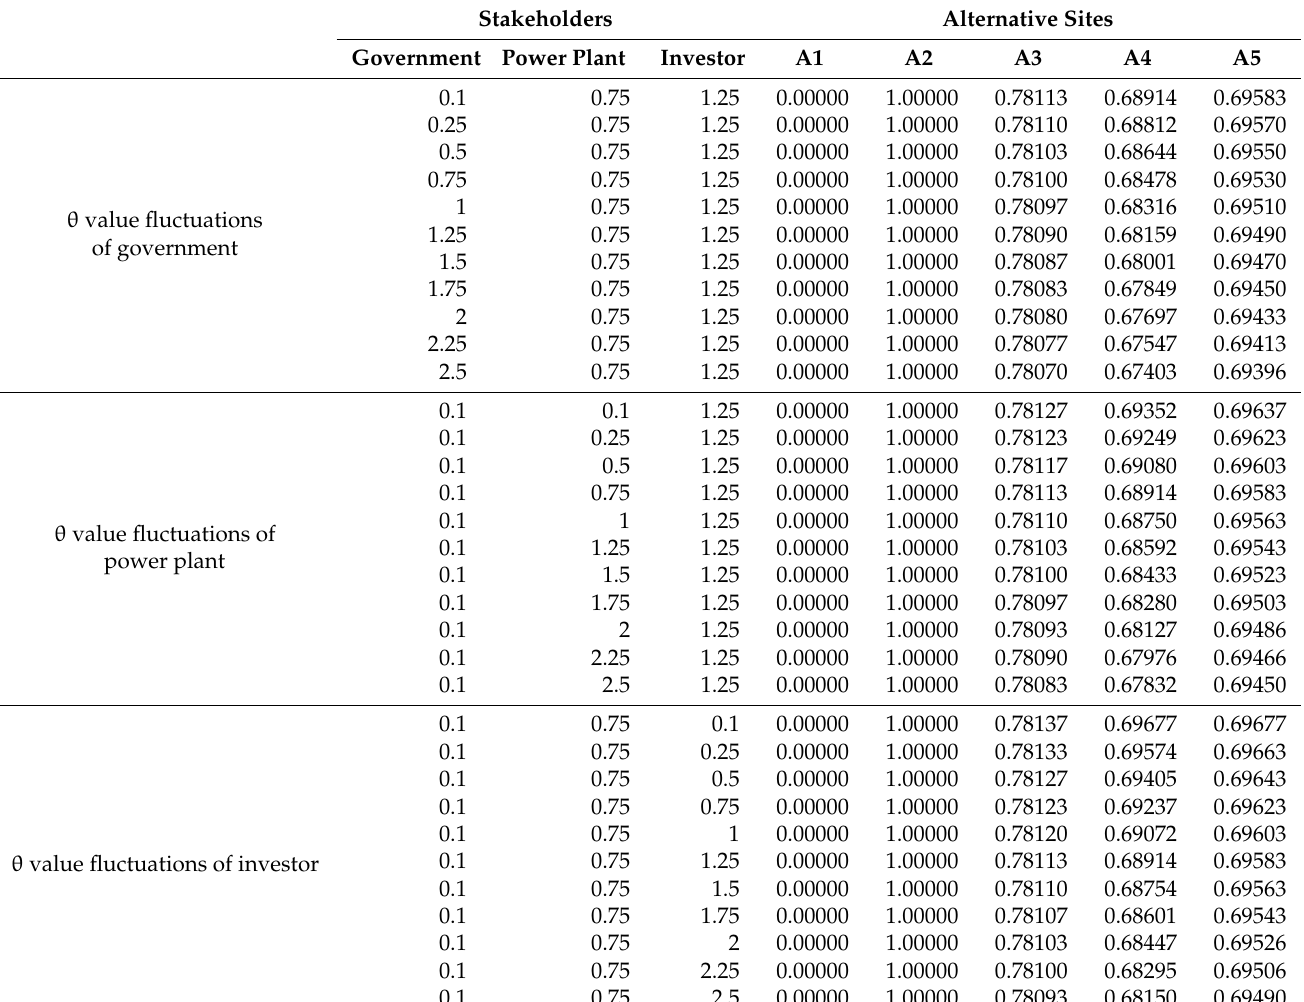
Table 4. Results of θ sensitivity analysis (single stakeholder risk preference